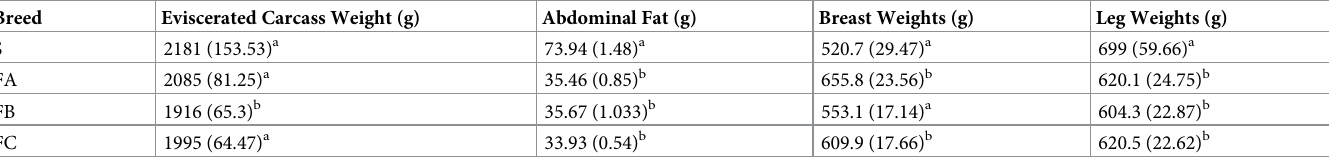
Table 10. The mean (SEM) eviscerated carcass, abdominal fat, breast weights and leg weights for the four breeds. Breed Eviscerated Carcass Weight (g)